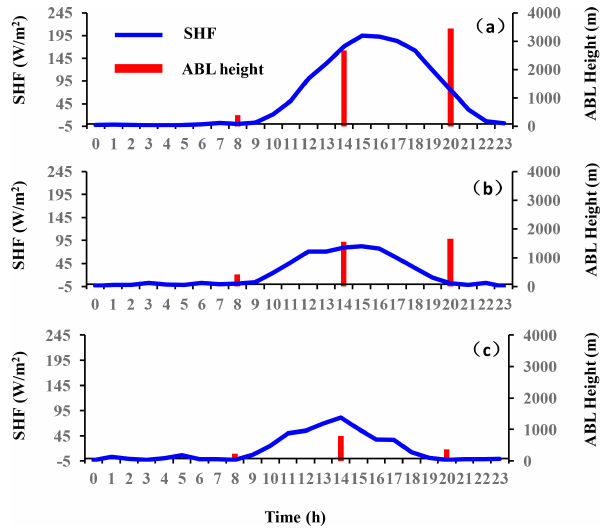
Figure 11. Diurnal variations in surface sensible heat flux (blue) and the ABLH (red) averaged over the study period at (a) SQH, (b) NQ, and (c) LZ stations.